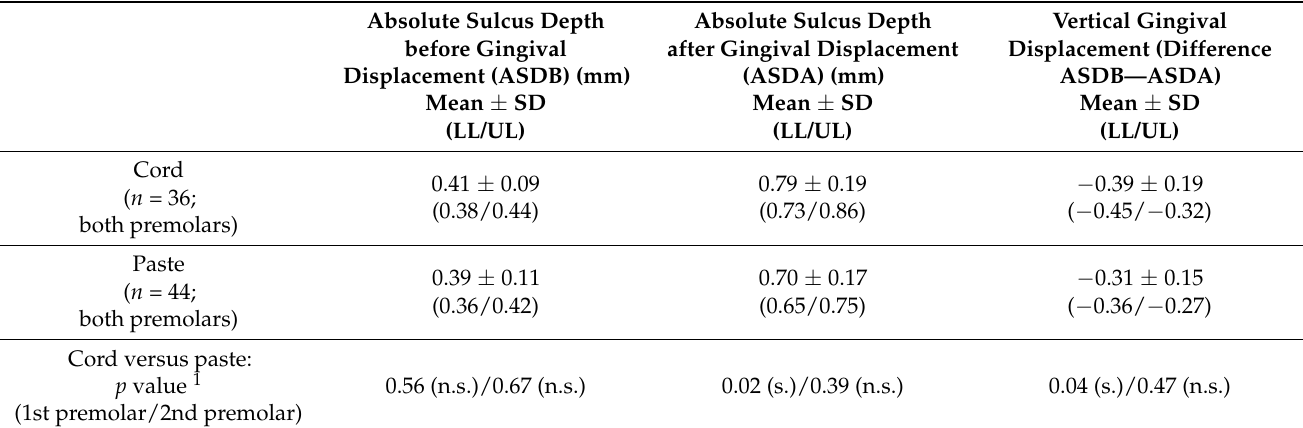
Table 2. Absolute sulcus depth before (ASDB) and after (ASDA) gingival displacement and vertical gingival displacement for the cord and the paste